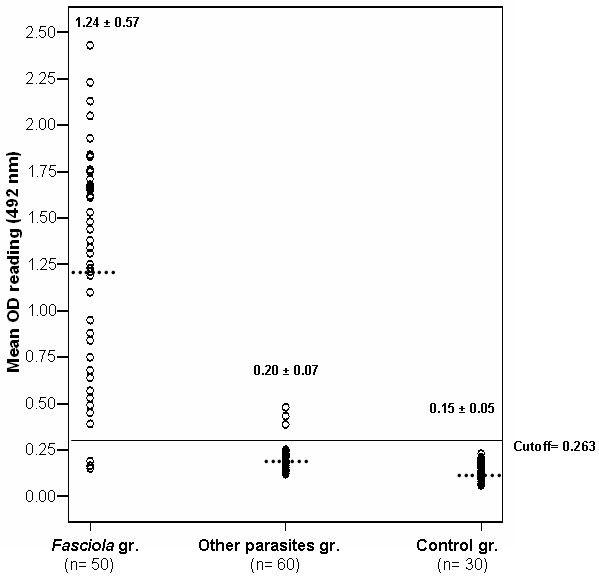
Level of Fasciola ES antigen detected in serum samples of different studied groups measured by sandwich ELISA (OD reading at 492 nm). The horizontal line represents the cut-off value of the assay (the lower detection limit). Dotted lines represent the mean OD value.